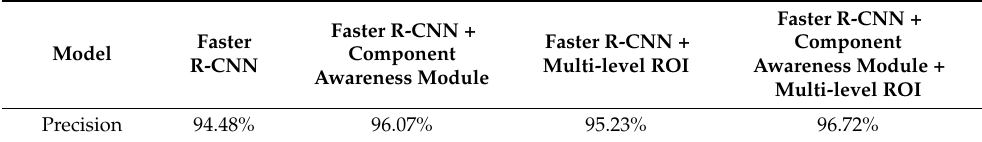
Table 3. Ablation Study.